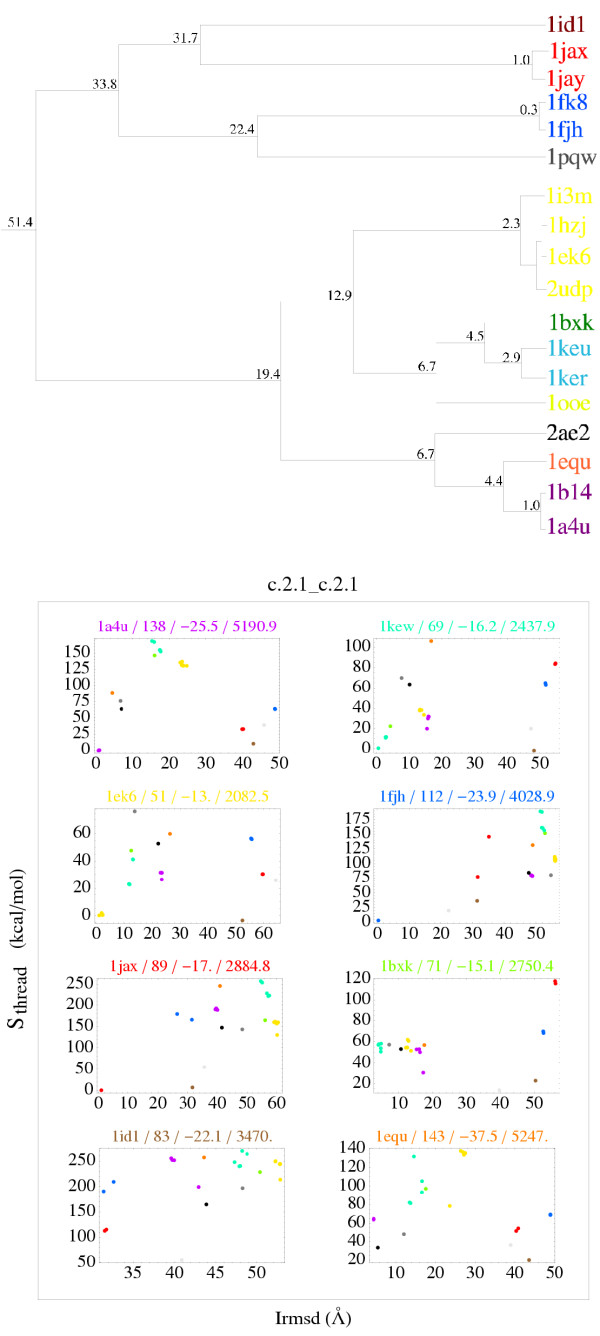
c.2.1 group: representation of binding modes. Above, tree representation of binding modes. Nodes are labelled with the mean Irmsd (Å) between leaves. Below, Sthread vs. Irmsd relative to the Xray structure. Each panel corresponds to an Xray complex and is labelled with its PDB code, number of residue-residue contacts, Eint (kcal/mol), and buried surface area (Å2). Each point corresponds to the threading onto a particular template; the color identifies the template; the point representing the Xray structure (zero Sthread zero Irmsd) is not shown.